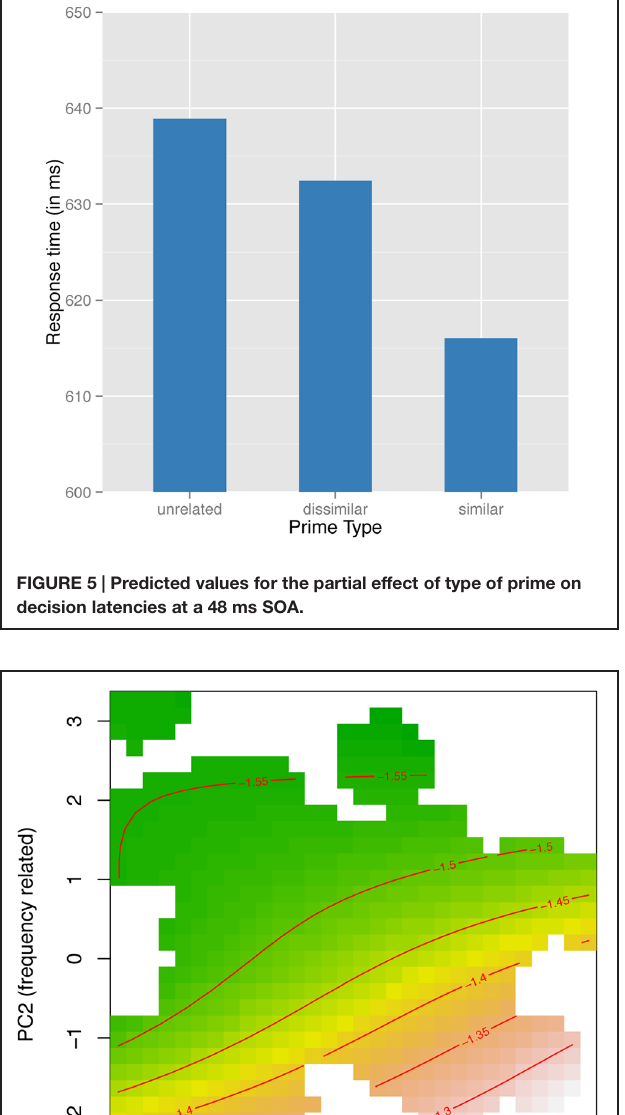
course of the experimental session. Admittedly in Experiment 1, when one considered only those data points at the shortest SOA (34 ms), the advantage of transparency based on the contrast of semantically similar and dissimilar prime target pairs was sta- tistically significant [Wald’s test: χ 2 (1) = 25.674; p <